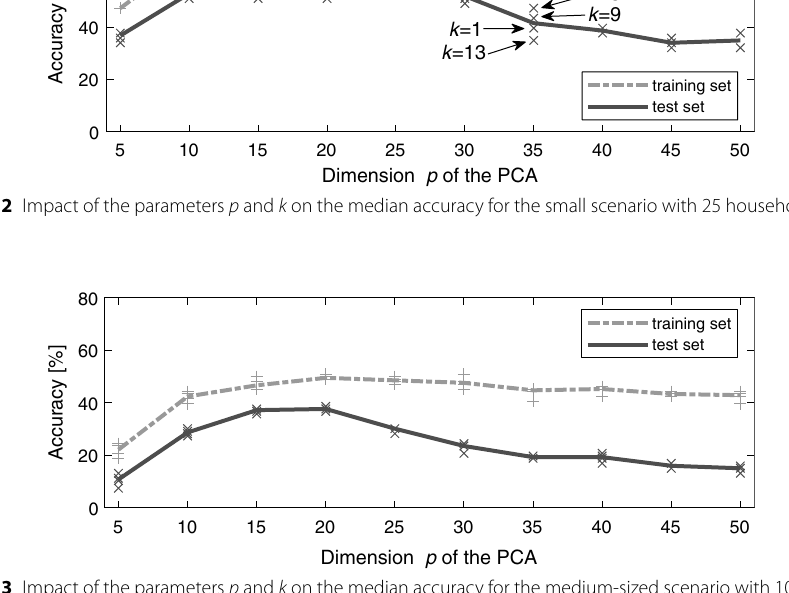
Fig. 3 Impact of the parameters p and k on the median accuracy for the medium-sized scenario with 100